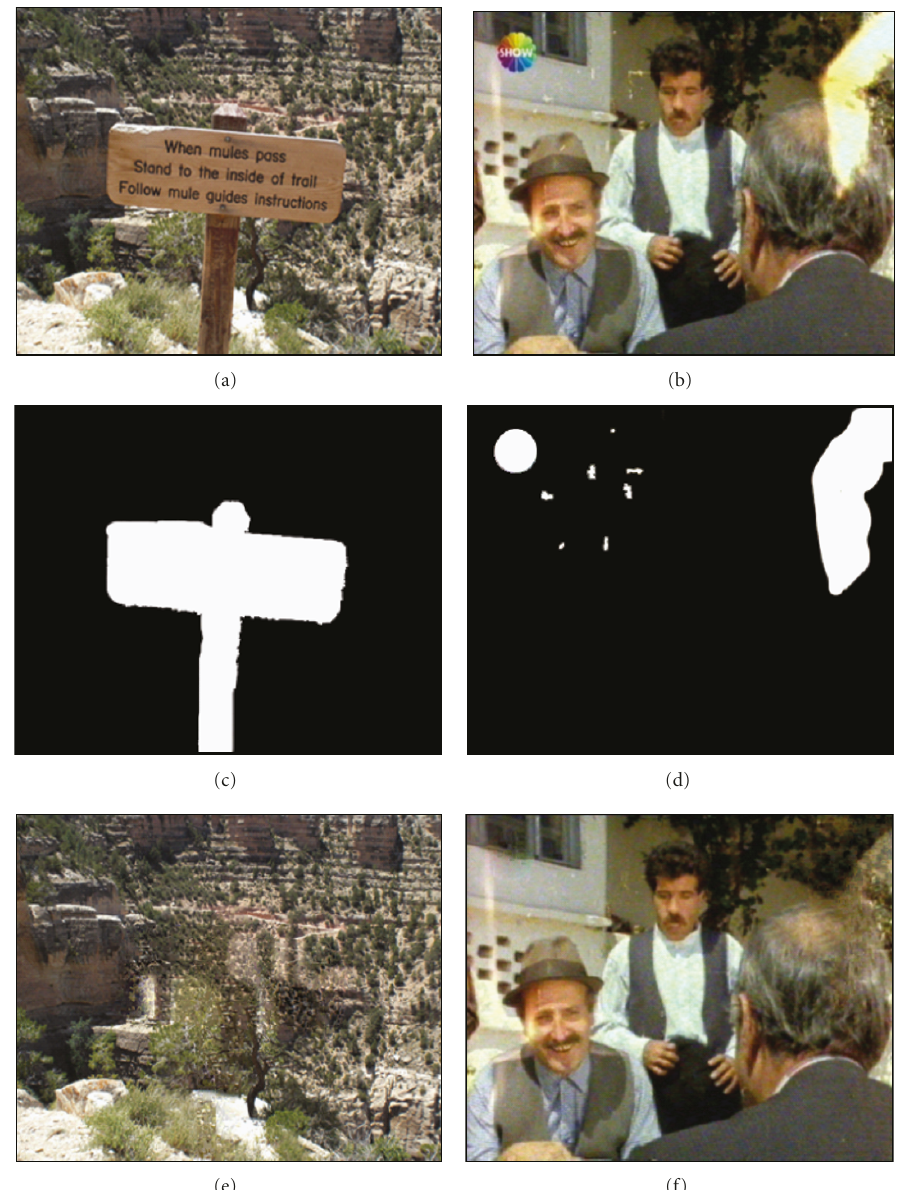
Figure 17: The input images (a) and (b) for image completion, the mask images (c) and (d) and output images (e) and (f) are generated by the proposed